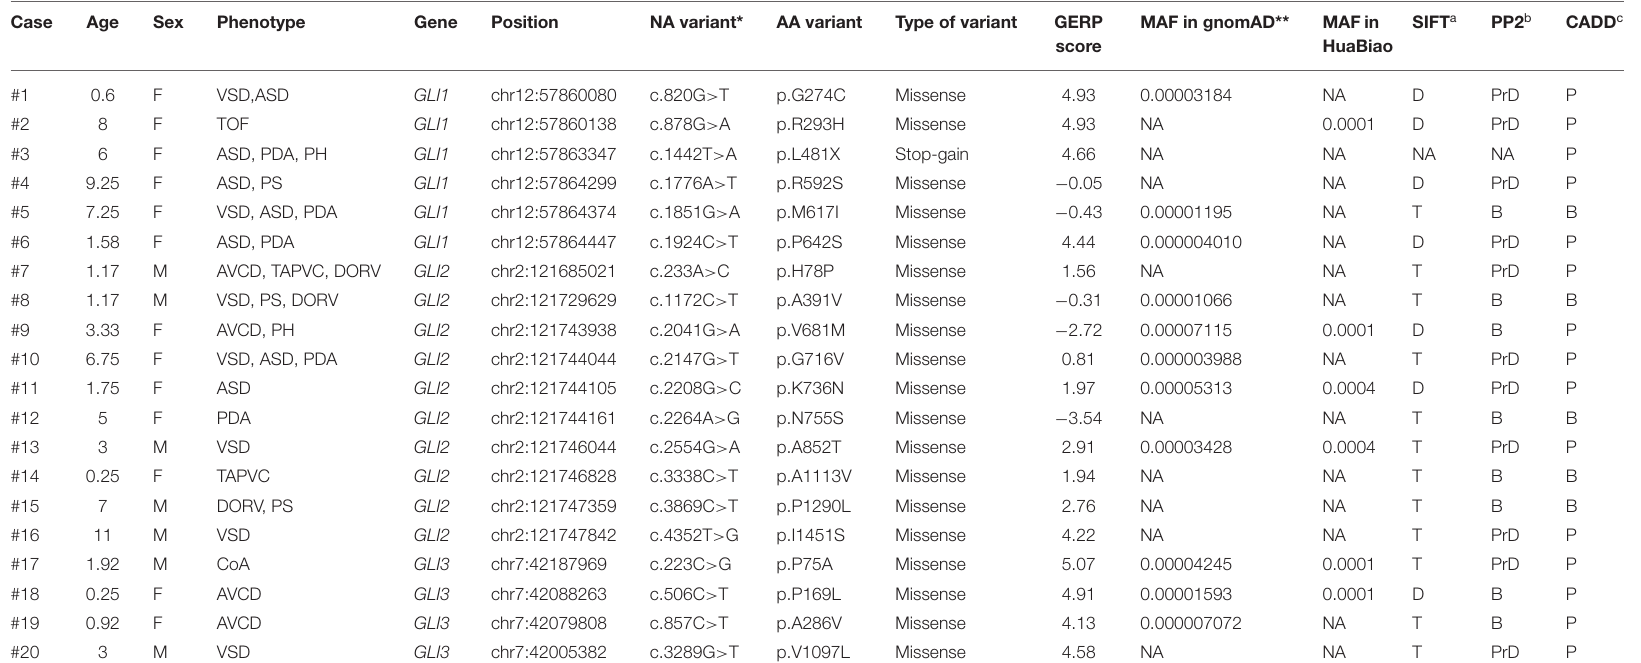
TABLE 2 | Bioinformatics analysis of patient-specific nonsynonymous rare mutations identified in GLI1-3 .